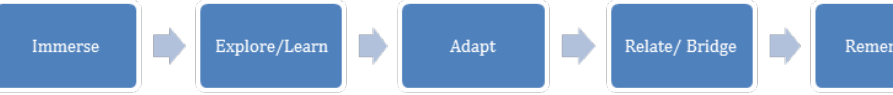
Figure 1. Non-Familial Caregiving